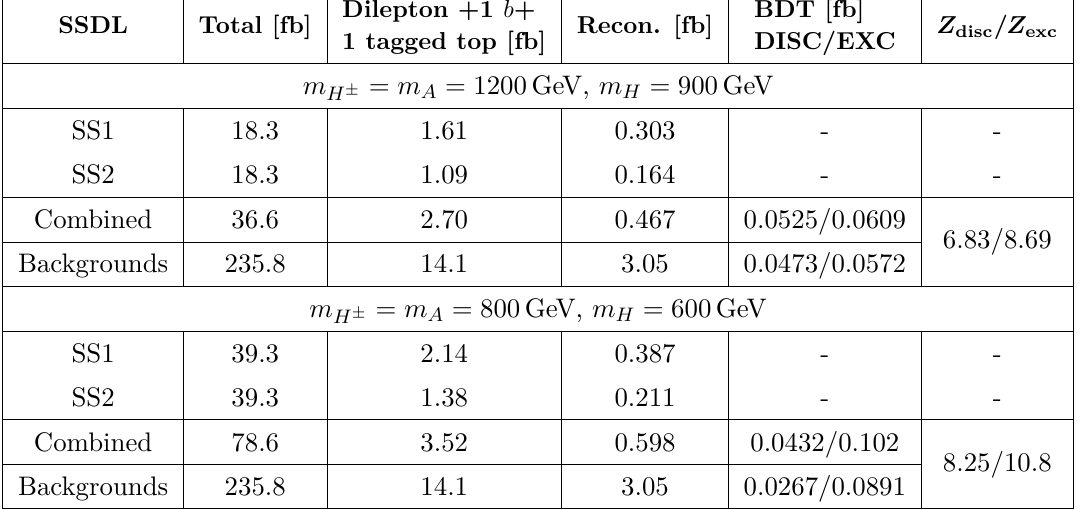
Table 3 . Cross sections of SSDL signal for two benchmark points and dominant SM backgrounds after different steps of